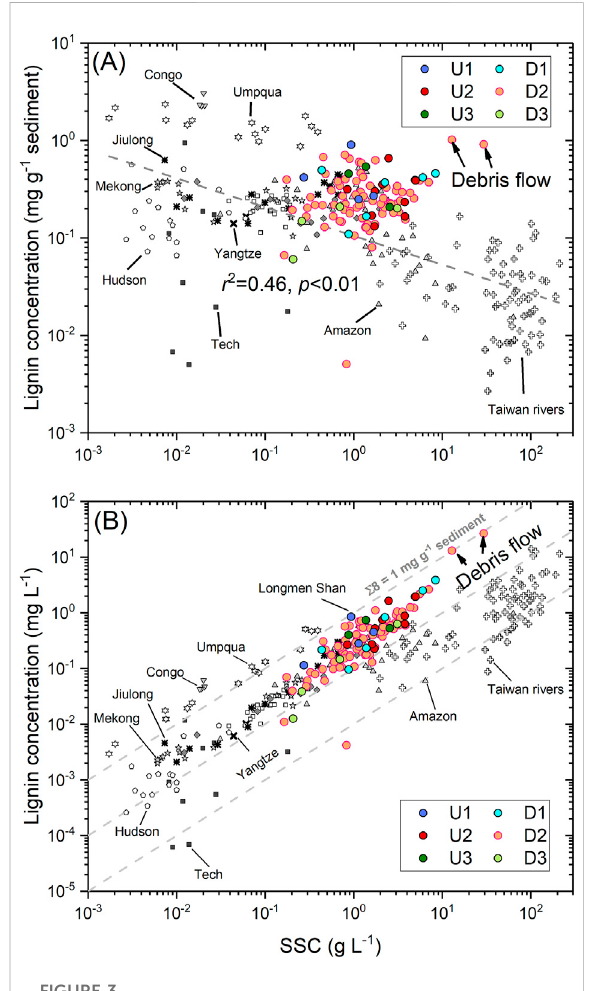
FIGURE 3 The relationship of lignin phenol concentration per unit mass (A) and per unit volume (B) with SSC of the upper Min Jiang, in the context of the world rivers modi fi ed after Bao et al. (2015) (black and grey symbols). The two highest SSC and lignin phenol concentration data in this study is immediately after the 2005 debris fl ow, highlighting the important role of intense rainfall inthein-landtectonic-activemountains.ThedashlineinpanelAis the power-law regression fi tted to data of global river suspended sediment using log-transformed least-squares regression. The dashlinesinpanelBshowtherangeofligninphenolconcentration per unit